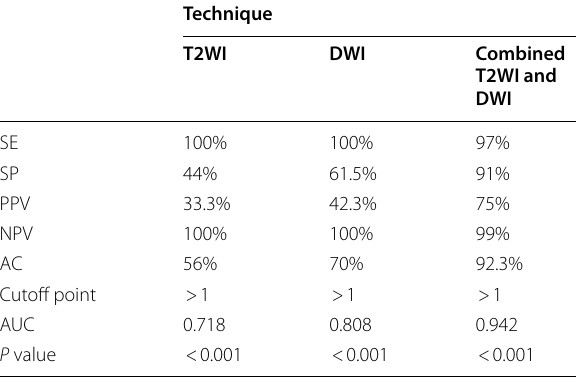
Table 11 Accuracy of MRI technique in prediction of abscess among studied patients